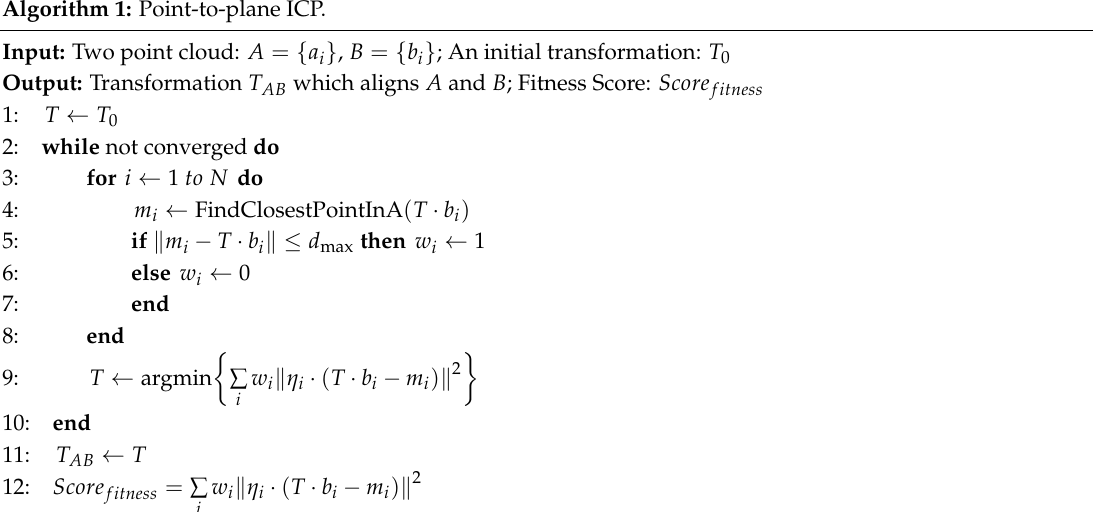
Algorithm 1: Point-to-plane